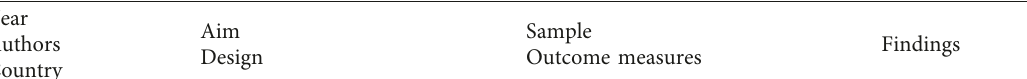
Figure 2: The PRISMA diagram of the study search strategy. Table 1: Summary of relevant studies on monitoring deteriorating